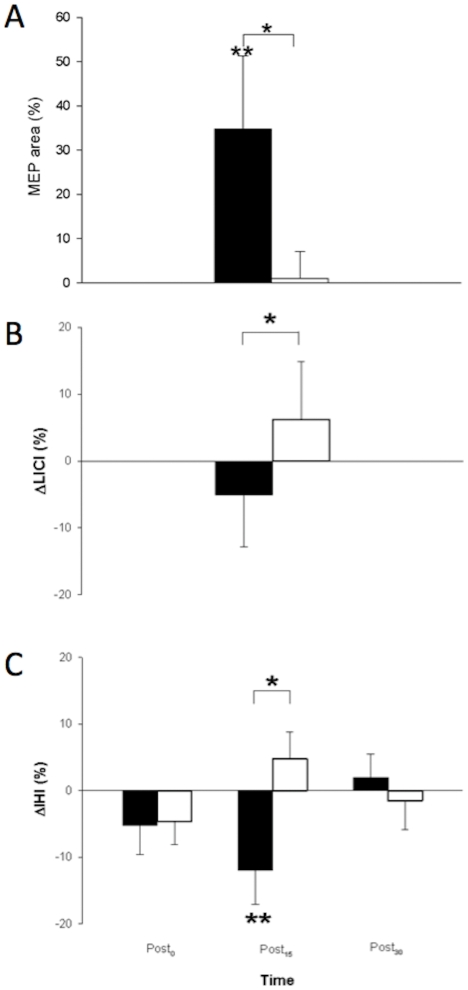
Neurophysiological effects after active-passive movement priming.Black bars are group averages from the mirror symmetric (MIR) session; white bars are group averages from the alternating (ALT) session. A. Corticomotor excitability increased after MIR but not ALT. There was a main effect of Pattern for non-conditioned ECR and FCR MEP area (Exp 1). Bars represent average ECR and FCR MEP area from 13 participants collapsed across all three post time points expressed as a percentage of baseline (100%). One-sample t-tests indicated significant MEP facilitation in both muscles after mirror symmetric but not parallel movement. B. Long interval intracortical inhibition (LICI) was modulated by Pattern (Exp 1). There was a main effect of Pattern for ΔLICI. Bars represent average change in LICI from ECR and FCR MEPs of 8 participants at each Post time point relative to baseline (0%). Relative to baseline, there was a non-significant trend for reduced LICI after the mirror session (P<0.1) and a trend for increased LICI in the alternating session (P<0.06). C. Interhemispheric inhibition (IHI) was modulated by Pattern and Time reduced after the MIR, but not PAR, session (Exp 2) indicated by a Pattern×Time interaction for ΔIHI. Bars represent average change in IHI from FCR MEPs of 13 participants at each Post time point relative to baseline (0%). At Post15, ΔIHI was less in the MIR session compared to the ALT session, but did not differ at other time points. One-sample t-tests indicated a significant reduction of IHI at Post15 relative to baseline after MIR only.